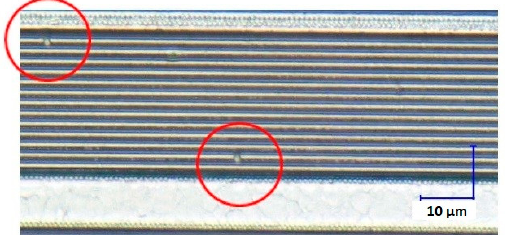
Figure 3. Image of deposited 1 µm spheres on top of the sensor’s surface. Spheres are in the middle of the red circles. The horizontal lines are the microelectrodes, which form the